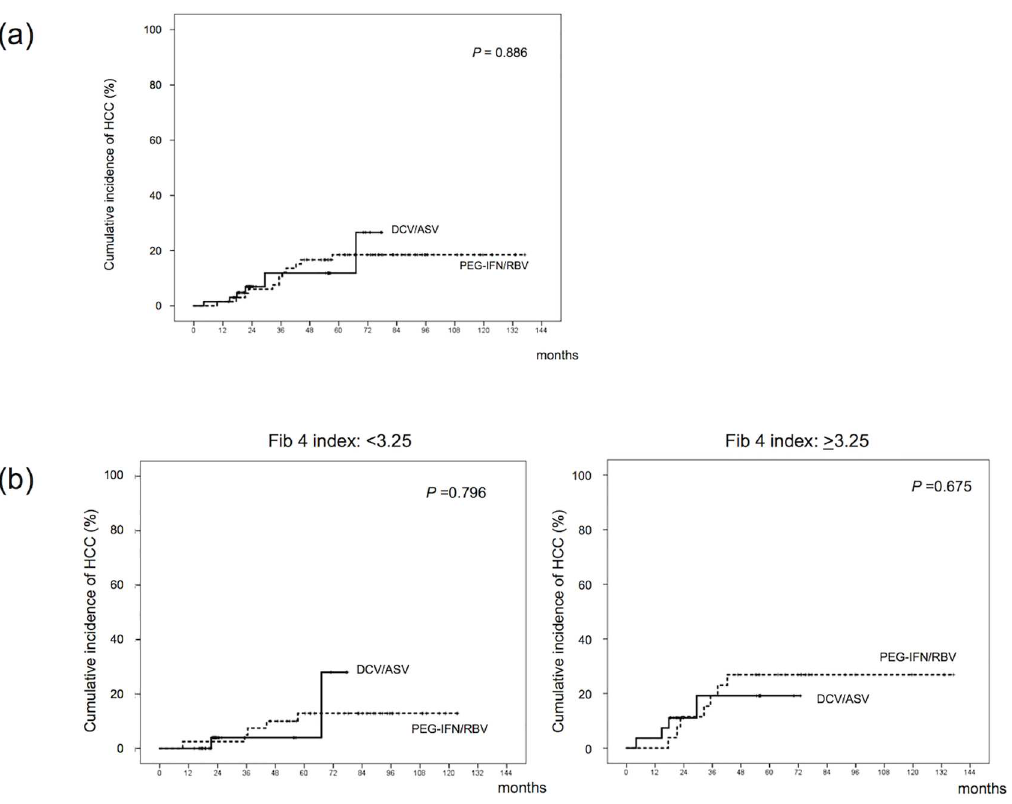
Fig 2. Cumulative hepatocellular carcinoma (HCC) development in propensity score matched patients. (a) 66 propensityscore-matched patients in each of peg-interferon and ribavirin(PEG-IFN/RBV) and daclatasvir plus asunaprevir(DCV/ASV) groups were analyzed.(b) Patients were groupedby FIB4 index.